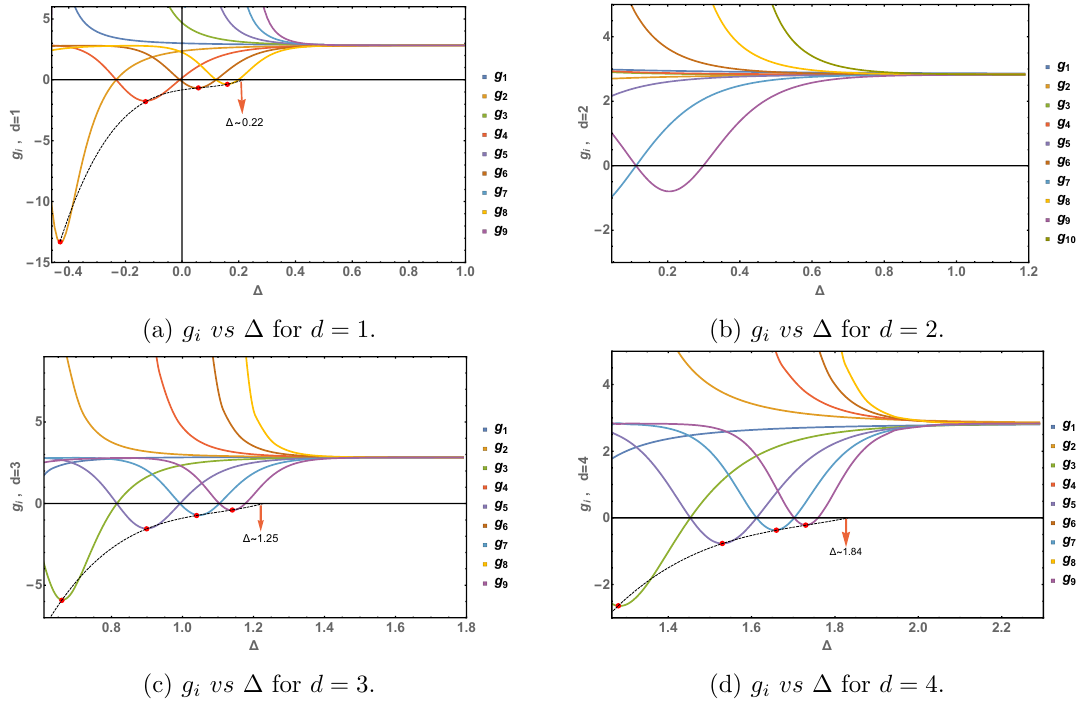
. For d = 1 ; 3 ; 4 a trend is 2